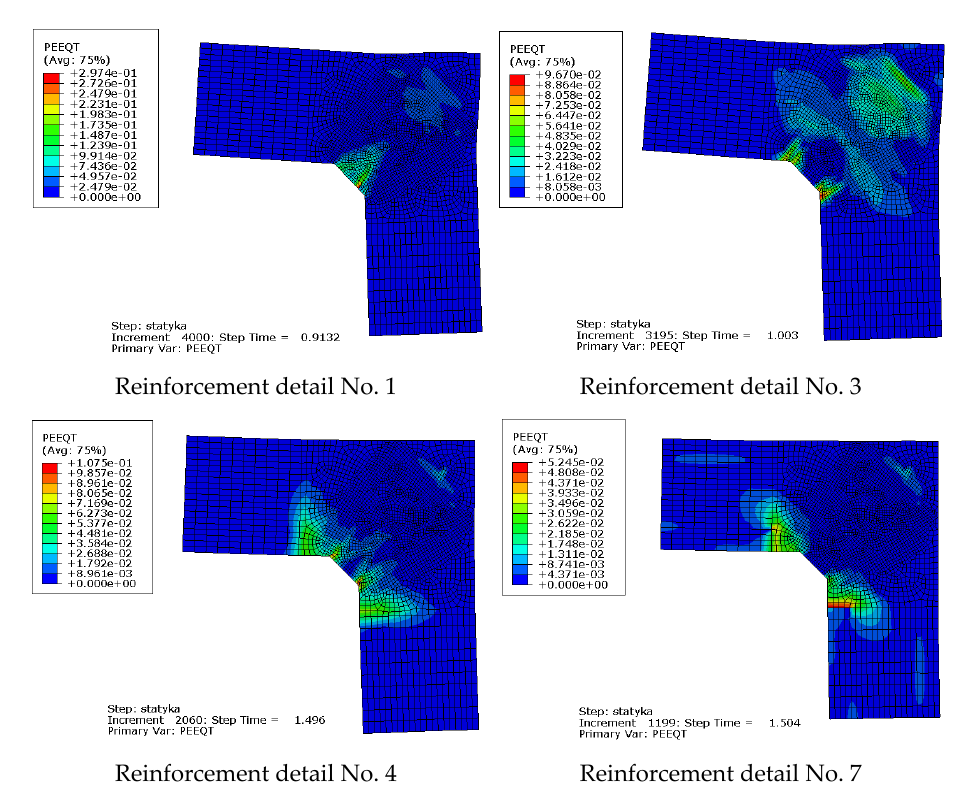
Figure 20. Equivalent plastic strains in tension PEEQT for chosen reinforcement details in the plane stress state.